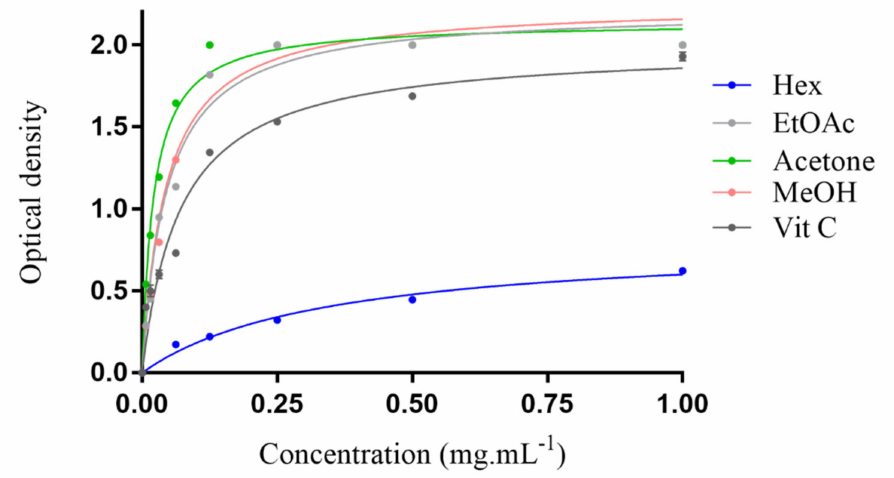
Figure 1. Ferric reducing antioxidant power (FRAP) of Erodium arborescens aerial part extracts and vitamin C.